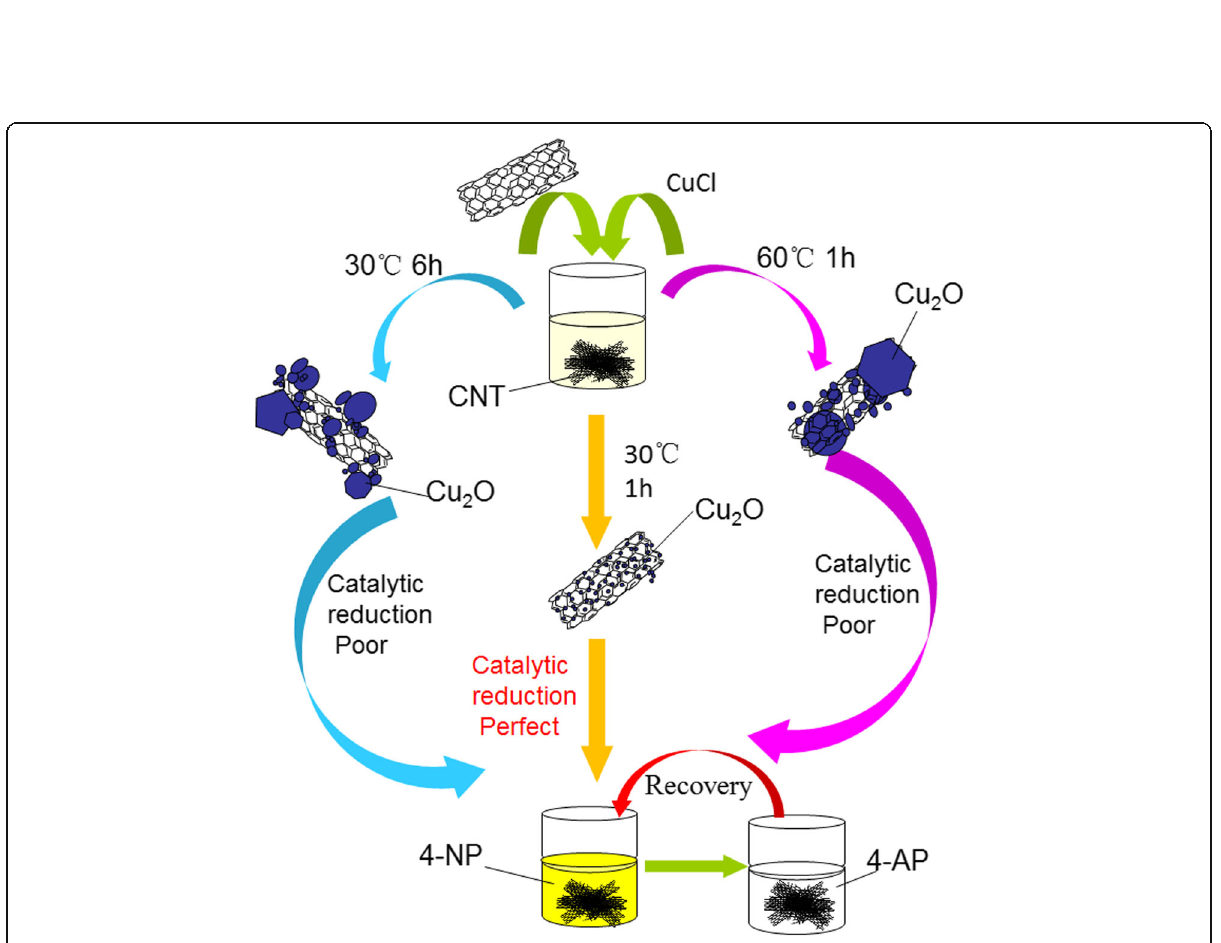
Fig. 7 Schematic illustration of the fabrication and catalytic reduction of the synthesized CNT-Cu 2 O